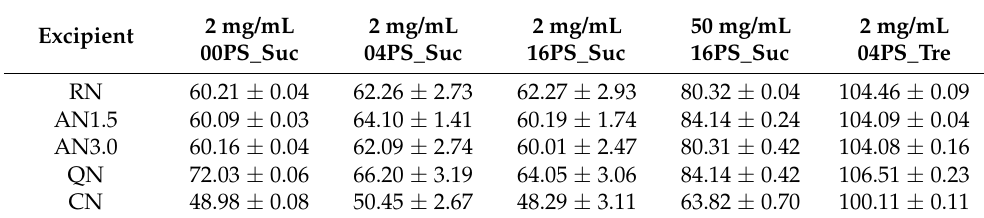
Table 6. Glass transition temperatures of the freeze-dried formulations [ ◦ C]. n = 2, values represent the mean value and the corresponding standard